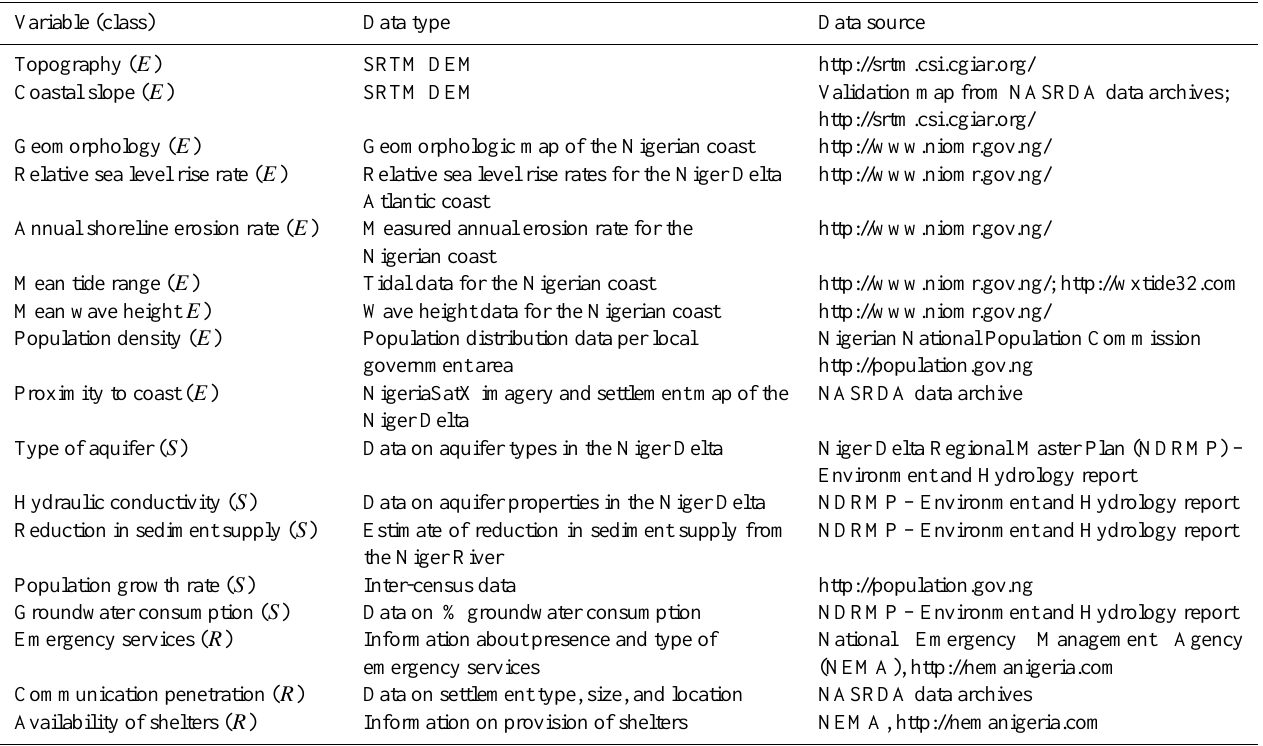
Table 1. List of selected variables for vulnerability assessment. Variable